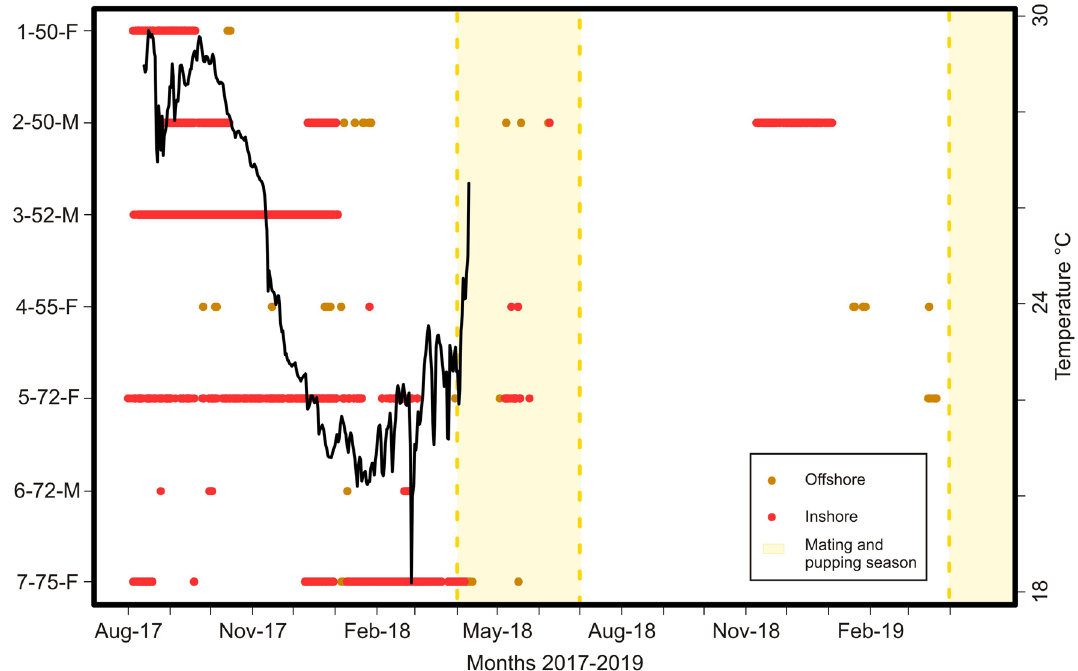
Figure 4. Mobula munkiana (n = 7) detections recorded at Espiritu Santo Archipelago between August 2017 and May 2019. Left axis specified code of the animal tag–disc width in centimeters–Sex (F: female; M: male). Ensenada Grande receivers are indicated in red (Inshore) and the rest of the Espiritu Santo Archipelago array is in orange (Offshore). Black line represents the temperature at Ensenada Grande from August 2017 to April 2018. Months of mating and pupping season are indicated in yellow.